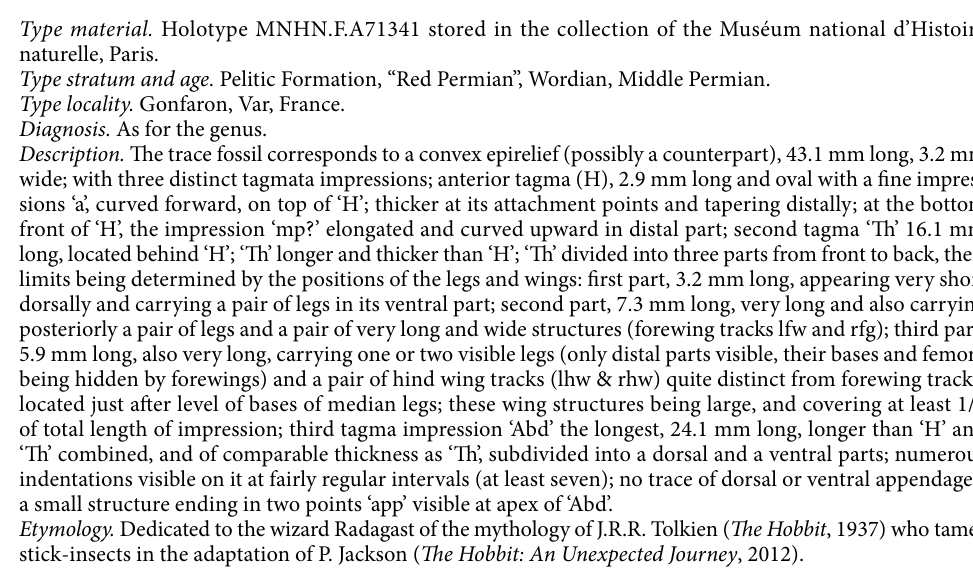
Figure 2. Phasmichnus radagasti gen. et nov. sp. Interpretative drawing. Abd abdomen; a antenna; app abdominal appendages; lfw left forewing; lhw left hind wing; H head; MeTh mesothorax; MTh metathorax; mp mouthparts; PTh prothorax; rfl right foreleg; rfw right forewing; rhl right hind leg; rml right median leg; rhw right hind wing. Drawing by A.L. Scale bar, 10